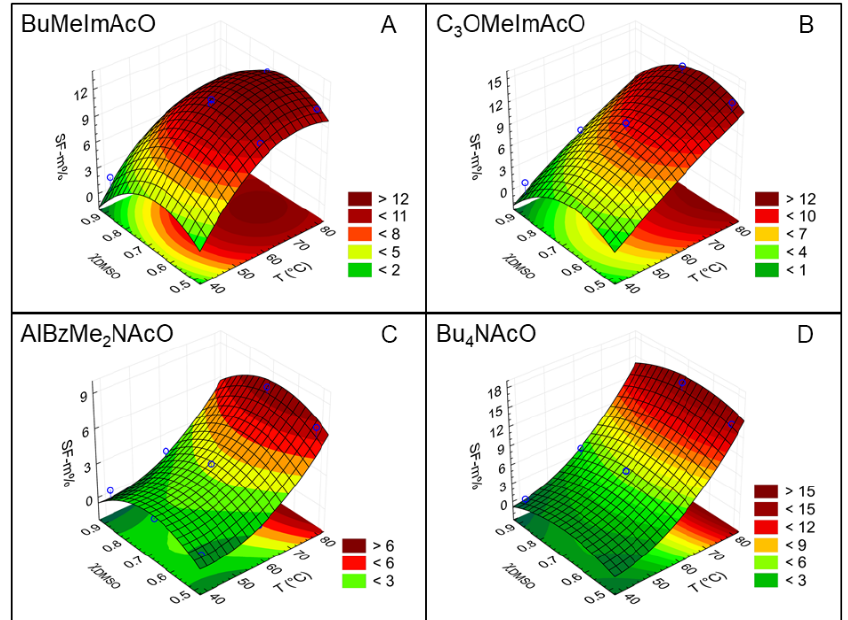
Figure 6. Response-surface plots for the dependence of silk fibroin dissolution on the temperature T , and mole fraction of DMSO, χ DMSO for the four IL-DMSO mixtures employed. We generated these plots from the data of Table S2, using second-order polynomials. Parts ( A – D ) refer to the ionic liquids studied. Table 4. Comparison of calculated and experimental values under conditions different from those employed to generate the mathematical model.